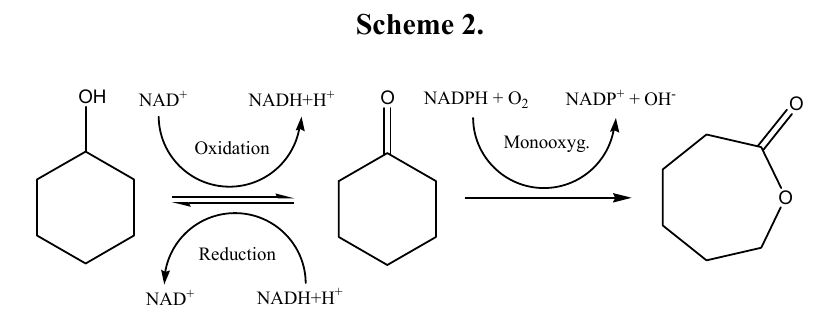
Table 1. Microorganisms giving yields higher than 20% in the oxidation of